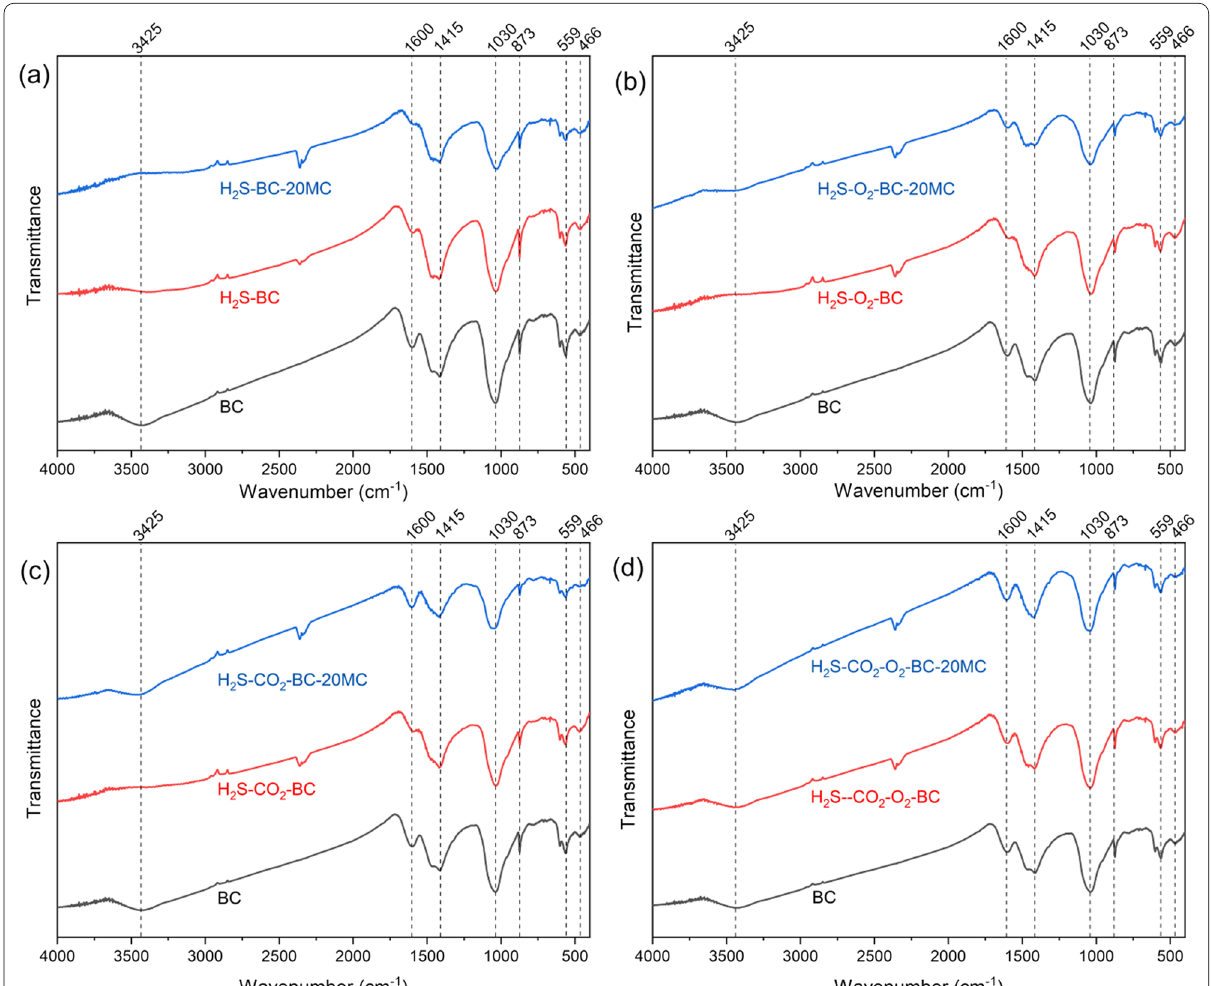
Fig. 4 The FTIR spectra of the DFW-BC before and after H 2 S adsorption. a is under pure H 2 S; b is under H 2 S H 2 S CO 2 O 2 . "BC" and "BC-20MC" mean dry DFW-BC and DFW-BC with 20% moisture content, respectively. 466–468 cm − 1 : Si–O–Si; 559 cm − 1 : + + Fe–O, P O; 873 cm − 1 : C–H; 1030–1050: C–O; 1415 cm − 1 : –COO; 1586–1602 cm − 1 : C =